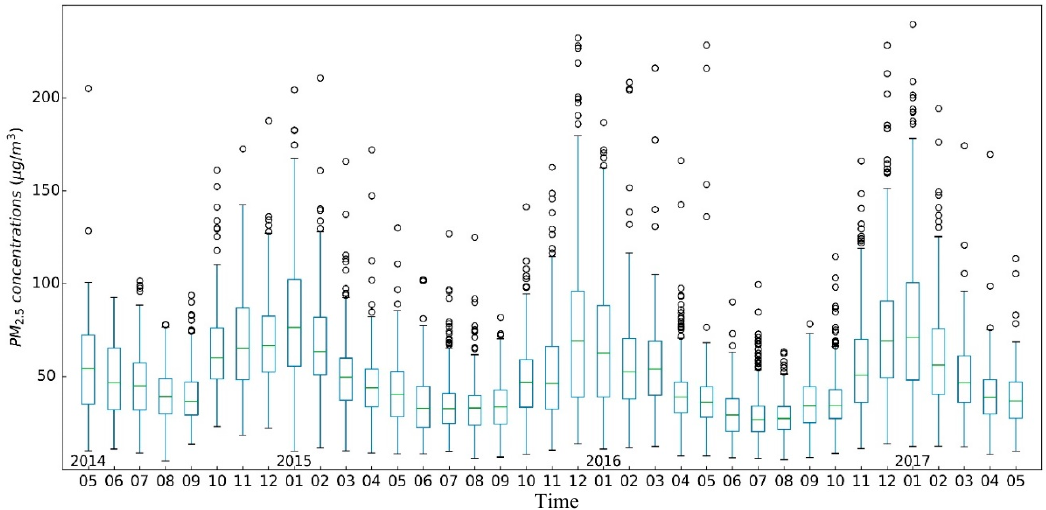
Figure 10. Box ‐ plot chart of PM (cid:2870).(cid:2873) monthly average concentration in Chinese mainland cities from May 2014 to May 2017. Figure 10. Box-plot chart of PM 2.5 monthly average concentration in Chinese mainland cities from May 2014 to May